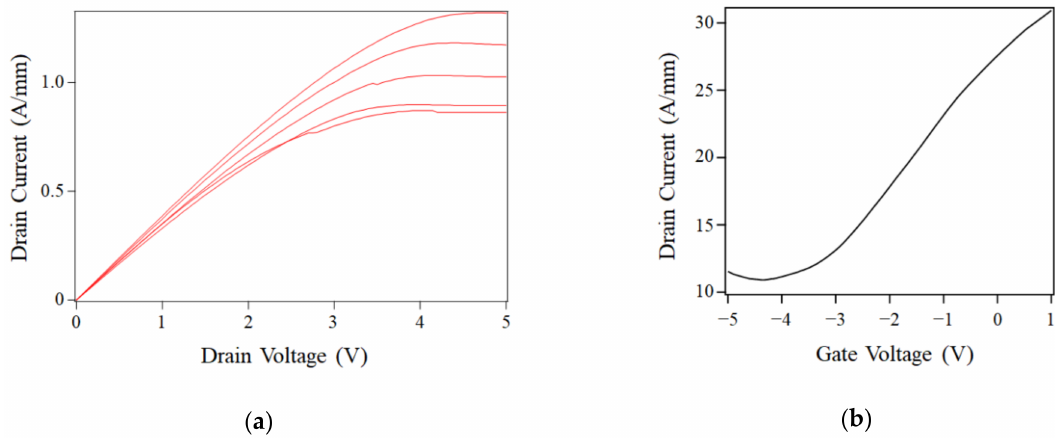
Figure 5. Electrical characteristics of a field-effect transistor using graphene grown on the hybrid SiC, ( a ) drain current–drain voltage with the gate voltages of 0 to 2 V (0.5 V step) and ( b ) drain current-gate voltage with the drain voltage of 10